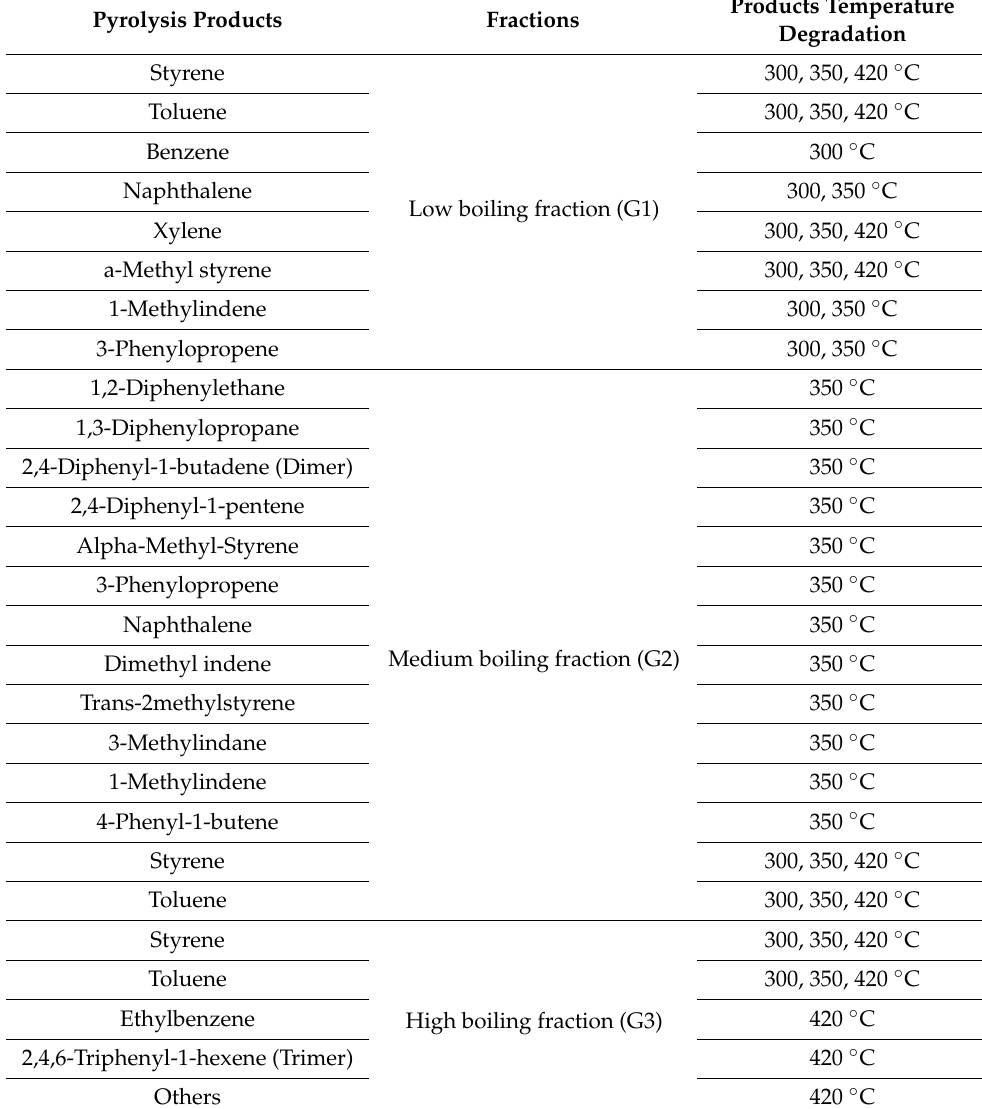
Table 3. Thermal degradation reactions of polystyrene during pyrolysis [54], with permission from